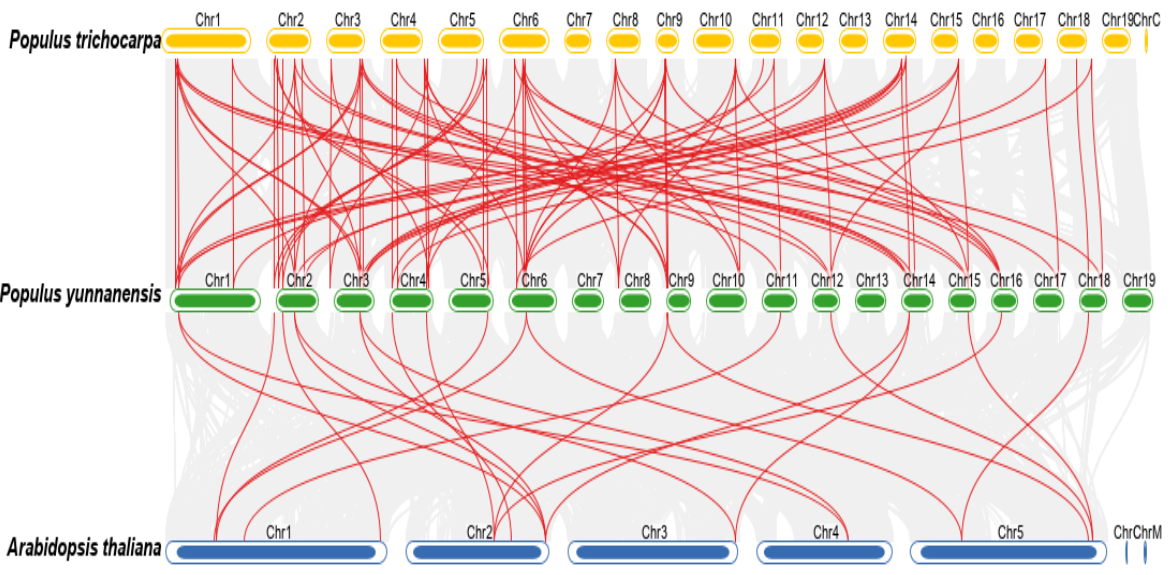
Figure 5. Collinearity analysis of ARFs between P. trichocarpa , P. yunnanensis , and A. thaliana . Chr represents chromosome-scale scaffolds. The putative collinear genes in P. yunnanensis and the other two species are marked in gray, while the syntonic ARF gene pairs are marked in red.